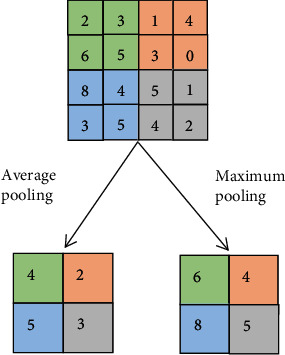
The pooling methods.